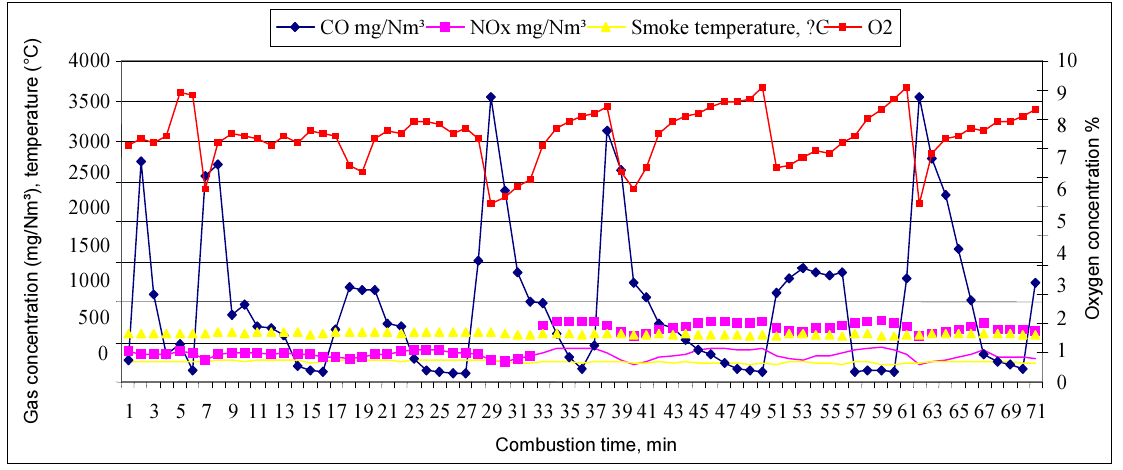
Fig. 5. Change of composition and temperature of smoke burning